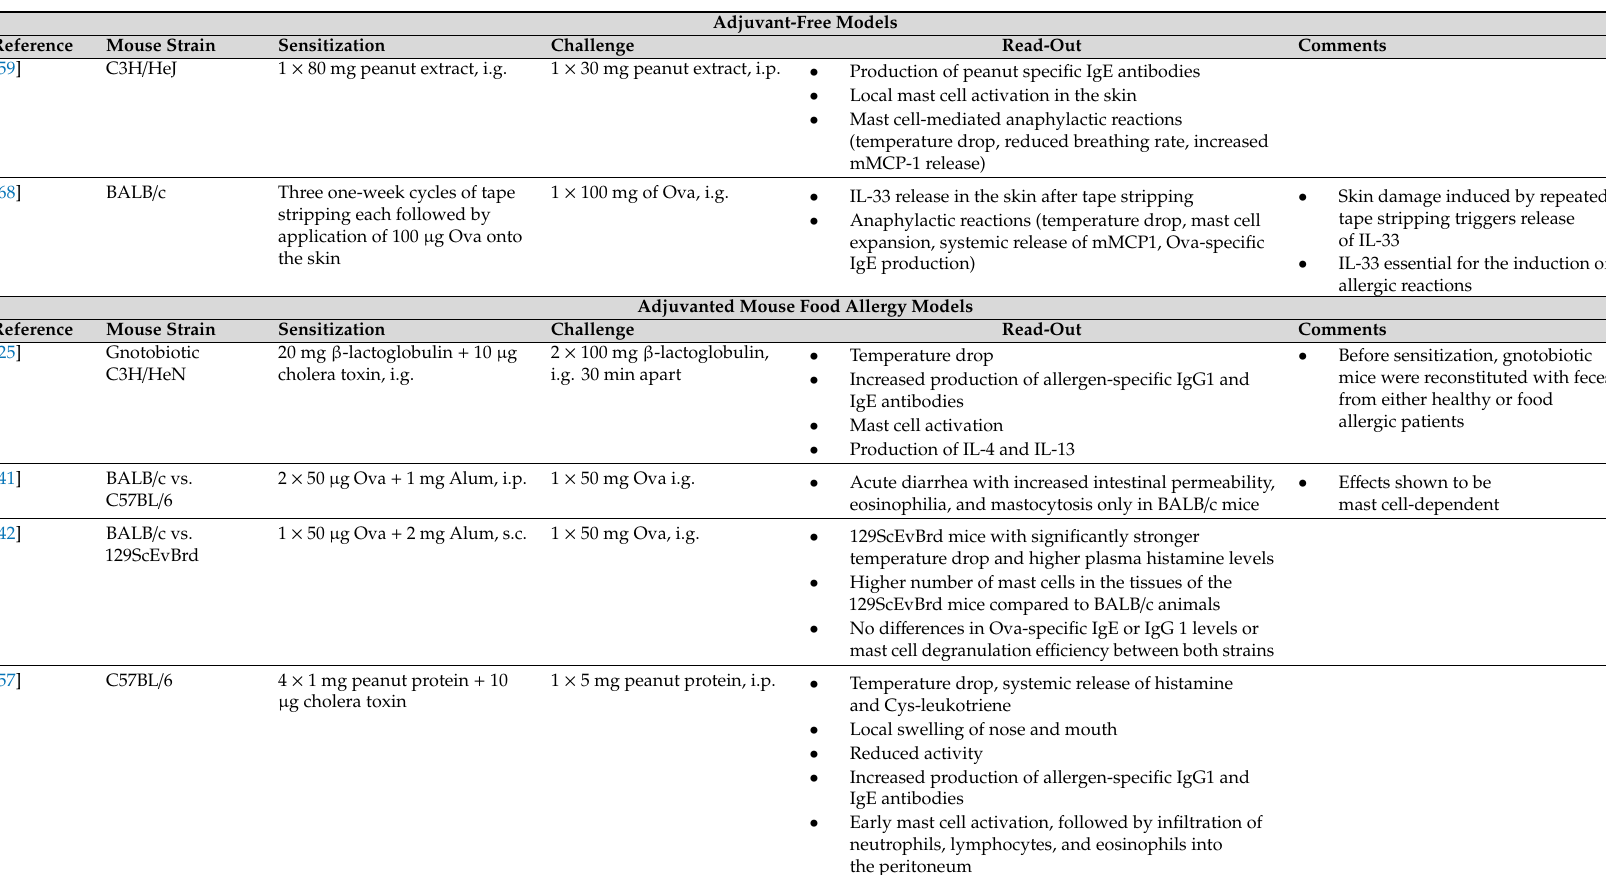
Table 1. Summary of the experimental mouse food allergy models discussed in this article. Abbreviations: mMCP1: mouse mast cell protease 1, Alum: aluminum hydroxide, CNS1: non-coding DNA sequence 1, WAS(P): Wiskott-Aldrich syndrome (protein), GATA3: GATA binding protein 3, PBMC: peripheral blood mononuclear